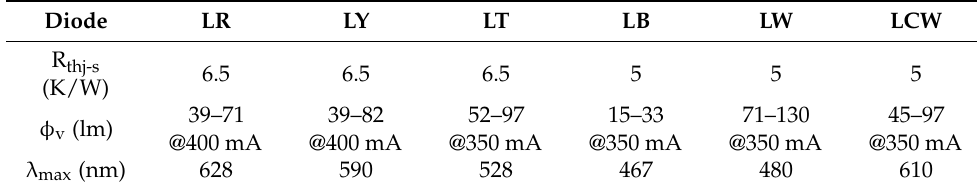
Table 1. Values of luminous flux Φ V , thermal resistance R thj-s and central wavelength of the investi- gated power LEDs [59].